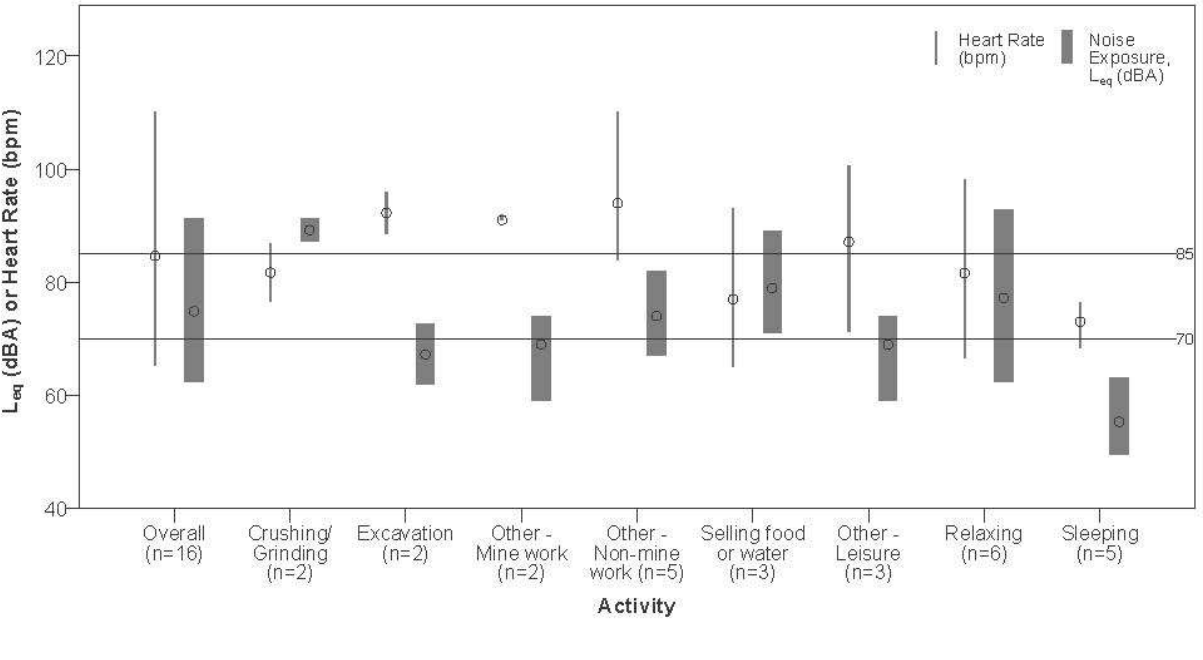
Figure 2. Paired noise and heart rate (HR) measurements. Bars represent range and dots represent means compared to the World Health Organization (WHO) 24-hour community noise exposure recommendation for hearing loss (70 dBA) and NIOSH